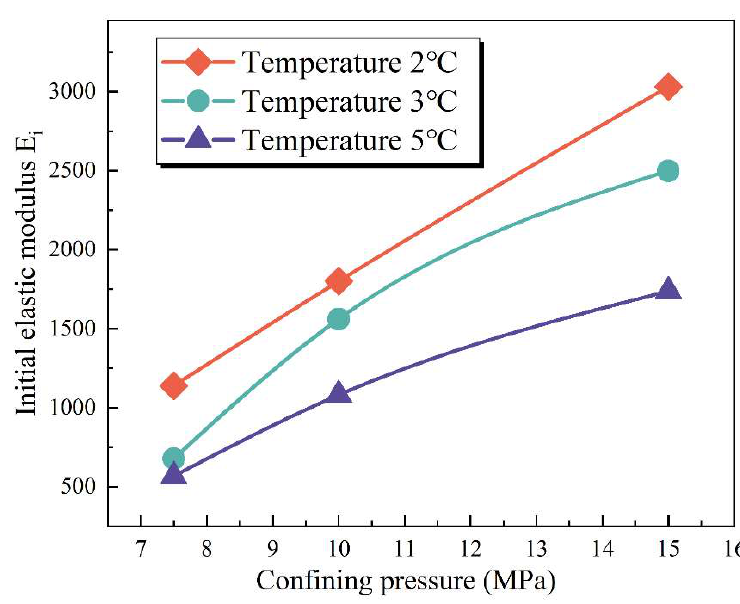
Figure 12. Variation of E i with T and σ 3 .